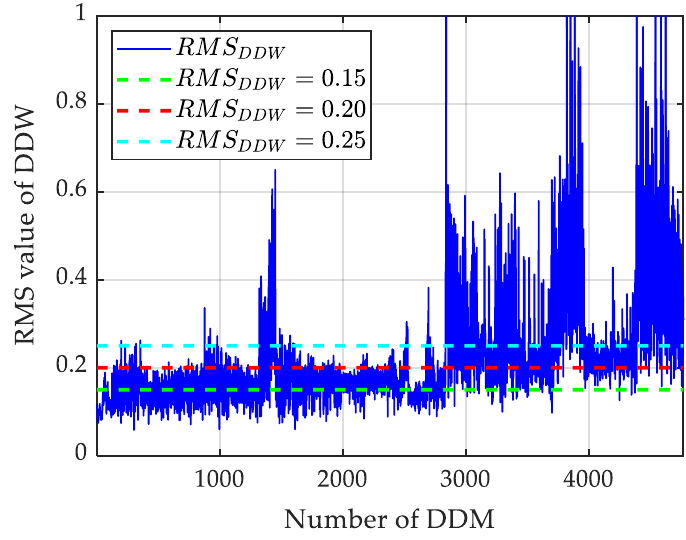
Figure 6. Root mean square (RMS) statistics of differential delay waveform. Blue line represents the RMS of DDW, red line represents RMS = 0.2, green line represents RMS = 0.15, and cyan represents RMS = 0.25.